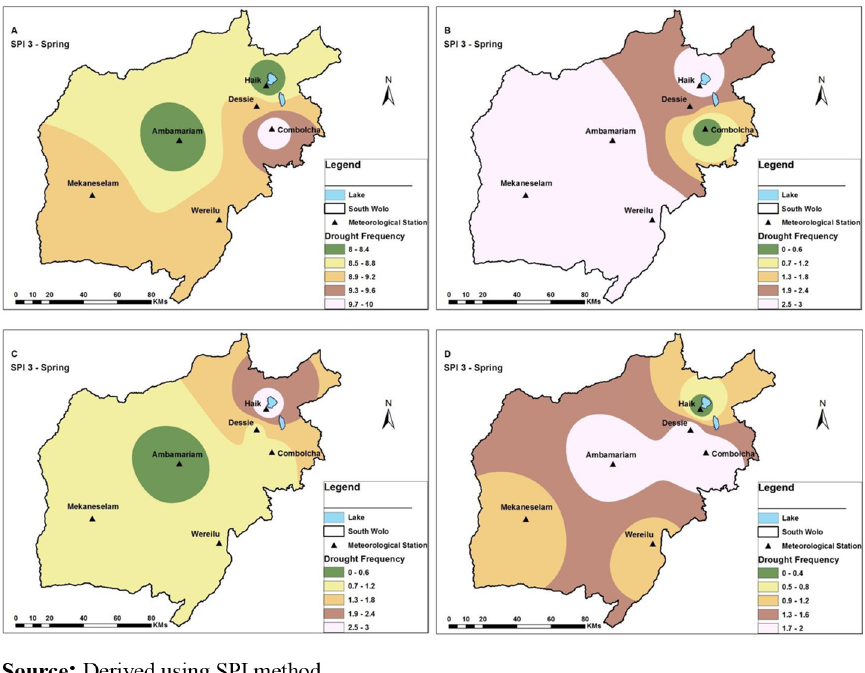
Figure 5. Spatial distribution